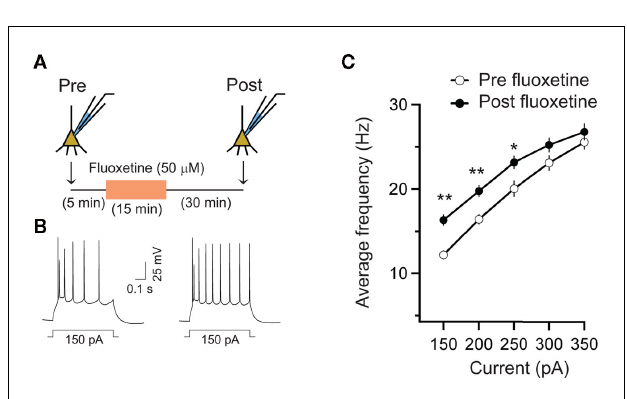
FIGURE 3 | In vivo acute fluoxetine administration increases the intrinsic excitability of LA principal neurons measured ex vivo . (A) Schematic representation of the experimental protocol. MaleWistar rats were injected with fluoxetine (10mg/kg, i.p.) or saline and sacrificed 60min later.Whole-cell patch clamp recordings were then carried out on excitatory principal neurons in the LA in the current-clamp mode. (B) Representative